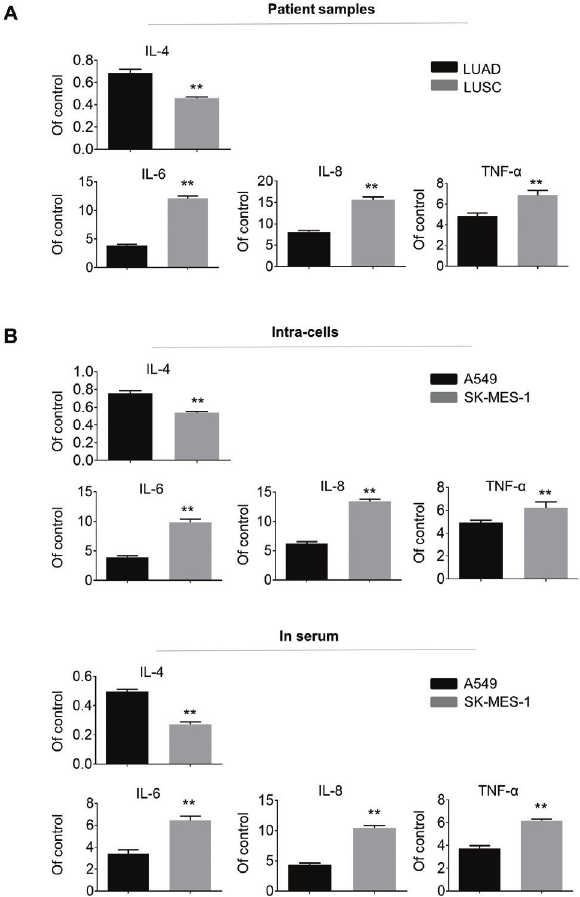
Fig. 4. The proinflammatory factors of A549 were more than that of SK-MES-1. A, the LUAD and LUSC patient specimens with the treatment of gemcitabine and cisplatin were dissociated. The levels of IL-4, IL6, IL-8, and TNF- α were determined by ELISA. Data represent mean ± SD of three independent experiments ( P < 0.01). B, the A549 and SK-MES-1 cell lines with the treatment of cisplatin (16 μmol/L) were placed into 96-well plates and incubated with fresh medium. The levels of IL-4, IL6, IL-8, and TNF- α of A549 and SK-MES-1 cells (upper panel) and their supernatant (lower panel) were detected by ELISA, and range lines represent mean ± SD of three independent experiments ( P < 0.01). LUAD, lung adenocarcinoma; LUSC, lung squa- mous cell